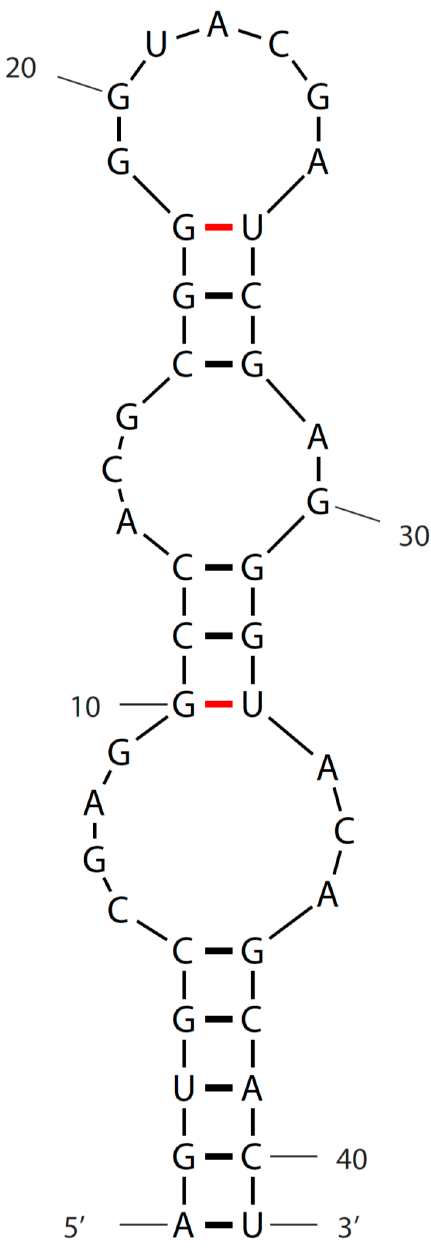
Figure 3. s2m secondary structure. The s2m element from Pheasant coronavirus strain ph/UK/6/99 was folded using mfold [16]. Non-Watson-Crick base-pairings are shown in red. For a more detailed folding with tertiary interactions and long-range contacts indicated, see [9].